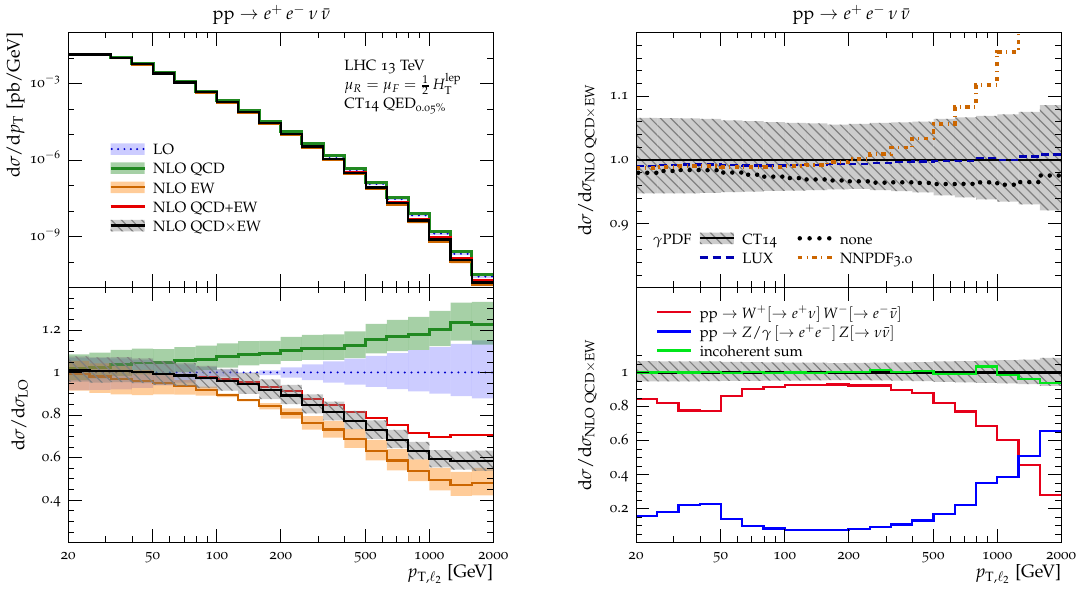
Figure 17 . Distribution in the transverse momentum of the subleading lepton, p pp e + e (cid:0) (cid:23) (cid:22) (cid:23) at 13 TeV. Details as in (cid:12)gure 16. ! the four-lepton invariant mass distribution m ‘‘(cid:23)(cid:23) shown in (cid:12)gure 22, interference e(cid:11)ects are so suppressed that they cannot be resolved at all with the available Monte Carlo